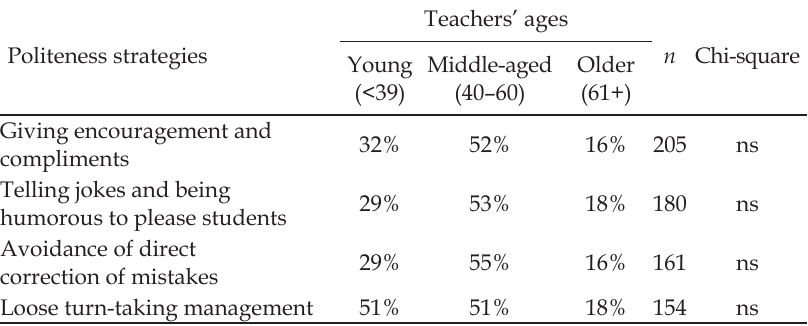
Table 3. Use of politeness strategies, by teachers’ ages ( N =